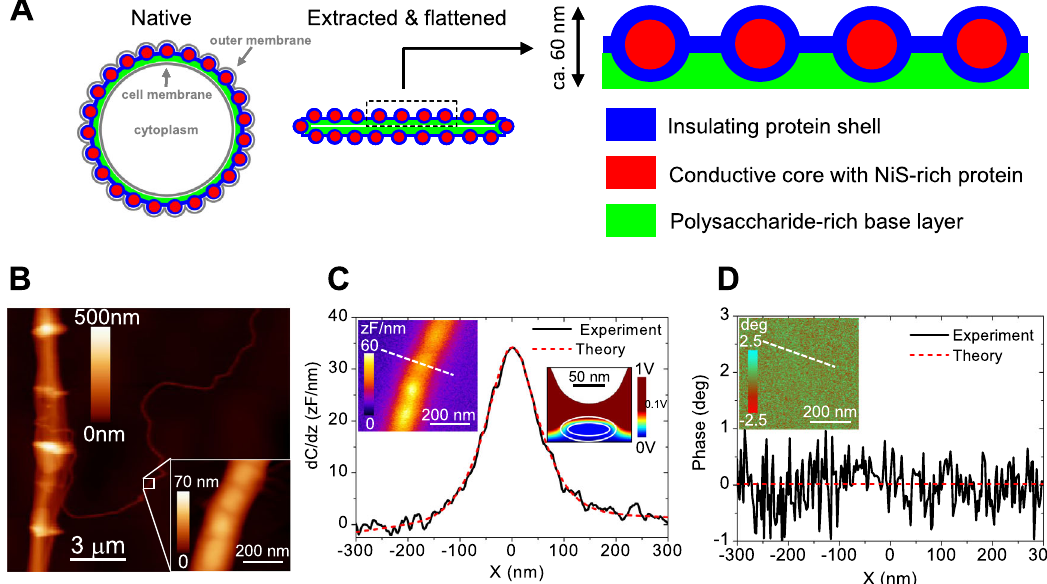
Fig. 5 Fiber sheath model and electrostatic properties. A Compositional model of the conductive fi ber sheath in cable bacteria based on the present fi ndings. Cross-sections through a fi lament in the middle of a cell are drawn and the number of fi bers has been reduced for clarity — a 4 μ m diameter cable bacterium has typically ~60 fi bers 5 . In its native state (right panel), the fi ber sheath is embedded periplasm between the cell and outer membrane and adopts a circular shape. After extraction, which removes the membranes and most of the cytoplasm and after drying upon a surface for analysis, the fi ber sheath fl attens, leading to two mirrored sheaths on top of each other (middle panel). The enlargement shows a section of the top sheath, which is the sample section probed by ToF-SIMS depth pro fi les and NanoSIMS images. Fibers are made of protein with a conductive Ni/S rich core and a non- conductive outer shell, and are embedded in a basal layer enriched in polysaccharide. B Topographic AFM image of a fi ber sheath with a single isolated fi ber detaching. The insert shows a detailed AFM image of this single fi ber. C SDM amplitude image (right insert) and cross-sectional pro fi le. D Corresponding SDM phase image (insert) and cross-sectional pro fi le. Constant height ( z = 66 nm) cross-section pro fi les are measured along the dashed lines shown in the left inserts. The red dotted lines in C and D represent model fi ts assuming the a fi ber has a conductive core and an insulating outer shell. The right insert in C shows a vertical cross-section of the electric potential distribution as predicted by the model. Model parameters: shell thickness, d = 12 nm; fi ber height, h = 42 nm; fi ber width w = 87 nm; relative dielectric constants of the shell and core, ε s = ω ε c = 3; conductivity of the shell σ s = 0 S/cm (insulating); conductivity of the core σ c = 20 S/cm 7 (see Supplementary Note 2 for treatment of SDM results and models tested). SDM analysis on a single fi ber is available only from one samples as this is a rare event, but results from a double fi ber and fi ber sheaths are in agreement (see Supplementary Note